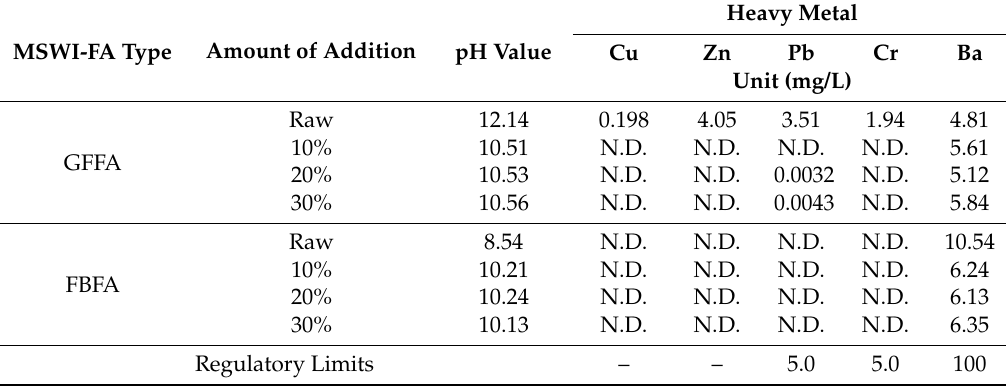
Table 7. The results of the leaching test according to USEPA SW-846 Method